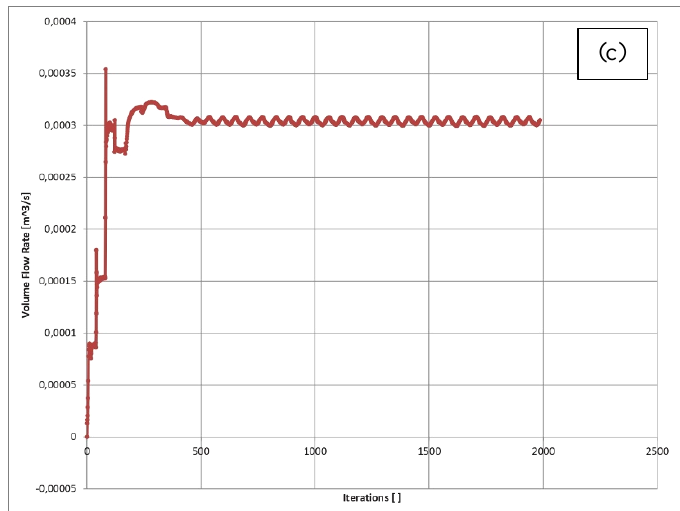
Figure 28. Liquid outflow pattern from a nozzle with a diaphragm for conditions when ∝ is more than 0 o but less than 90 o : (a) Calculation data; (b) A fragment of the adapted computational grid; (с) A fragment of the report on the calculation data convergence.